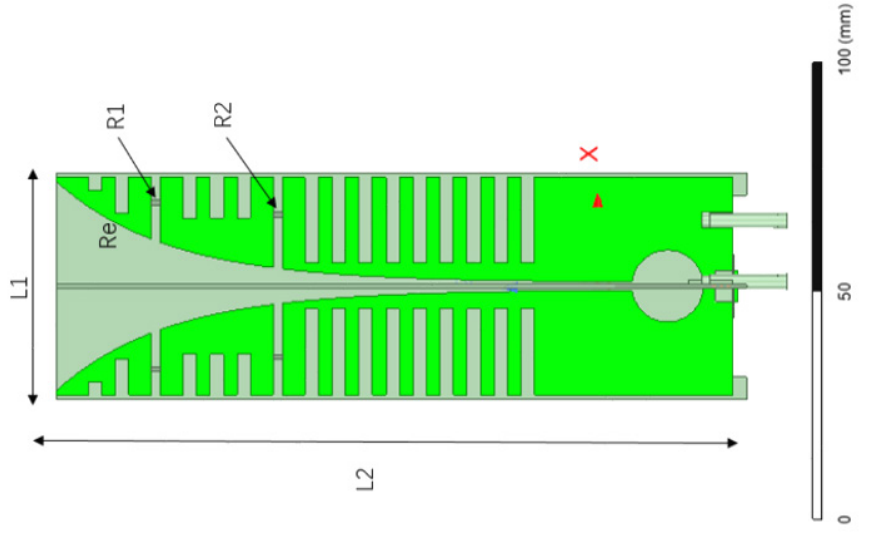
Figure 2. Structure diagram of ultra-wideband Vivaldi antenna.